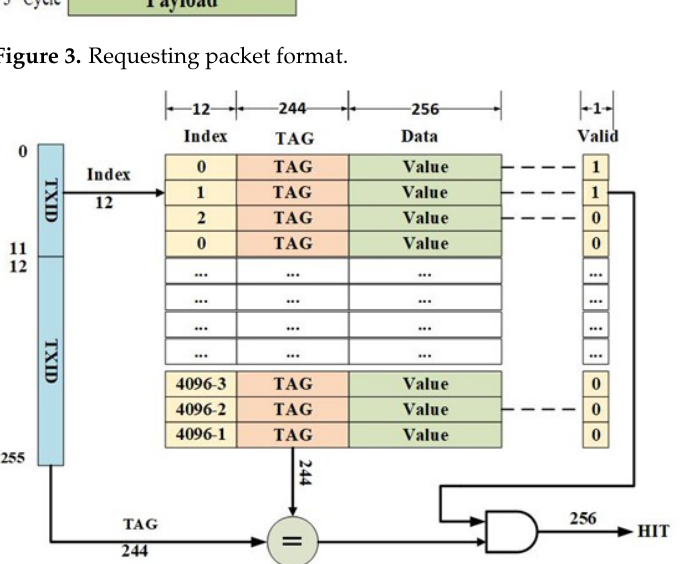
Figure 4. Layout of caching